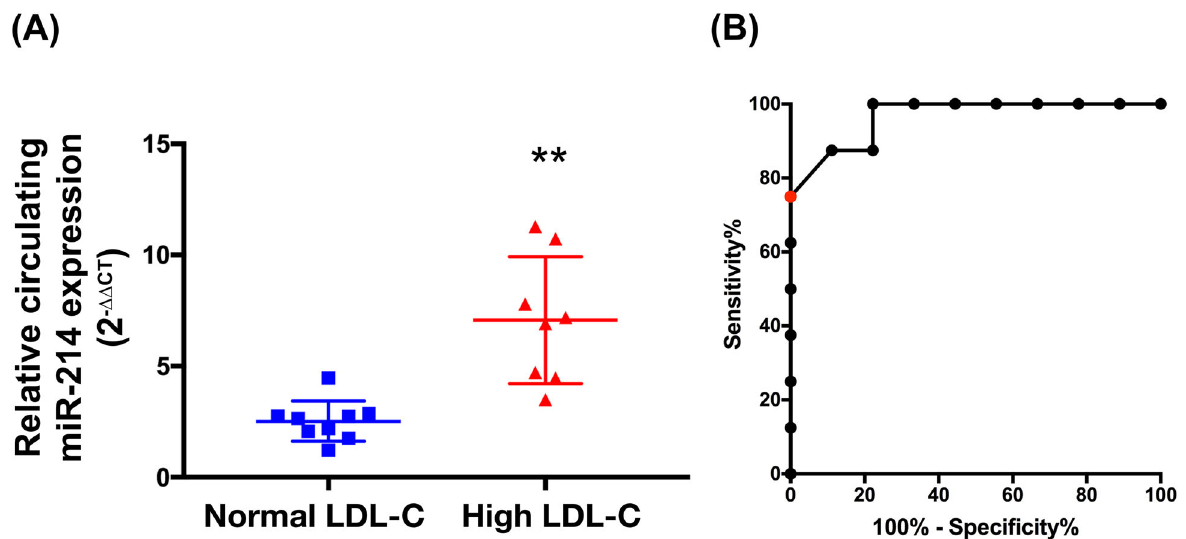
Fig. 6 MicroRNA-214-3p (miR-214) was upregulated in plasma from carotid artery stenosis patients with elevated LDL-C value. a The expression of miR-214 in plasma of CAS patients with normal LDL-C value ( n = 9) and CAS patients with high LDL-C value ( n = 8) were analyzed by qRT-PCR and normalized to corresponding cel miR-39 levels (Two-tailed Student ’ s t-test). Data are presented as the means± SEM. Differences were analyzed by Mann-Whitney test. ** P < 0.01 (Two-tailed Student ’ s t-test). b Assessment of the receiver operator characteristic (ROC) curve for the predictive power of the mir-214 circulating level in patients having high LDL-C level. The area under the ROC curve (AUC) was 0.96 ( p = 0 0013). The optimal cut-off point is labeled by the red solid